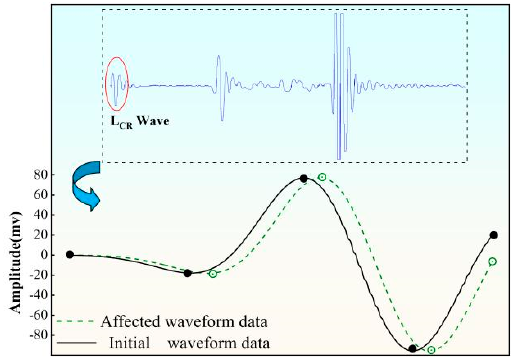
Figure 2. Waveform data before and after the L CR wave is affected.